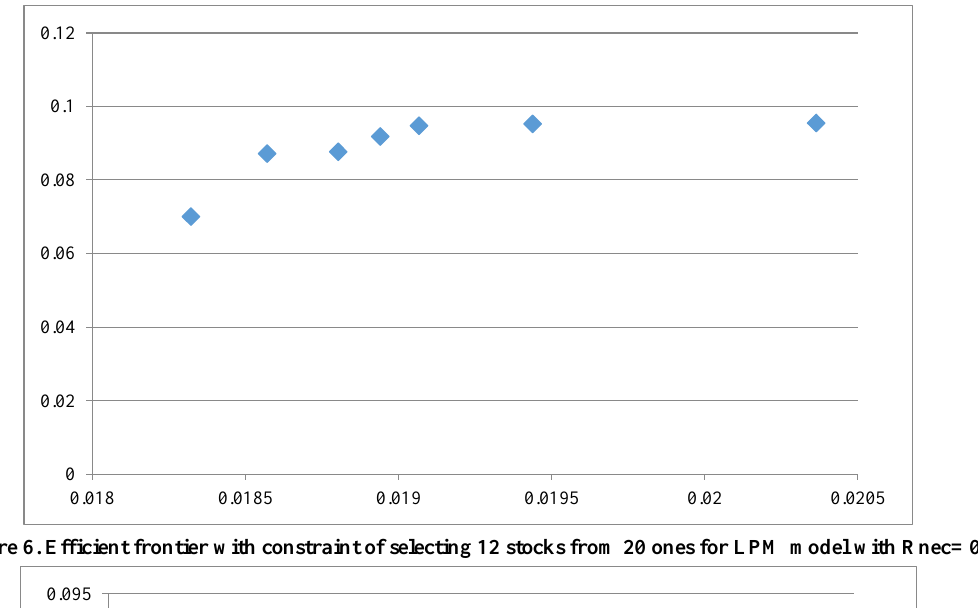
Figure 5. Efficient frontier with constraint of selecting 10 stocks from 20 ones for LPM model with Rnec= 0.